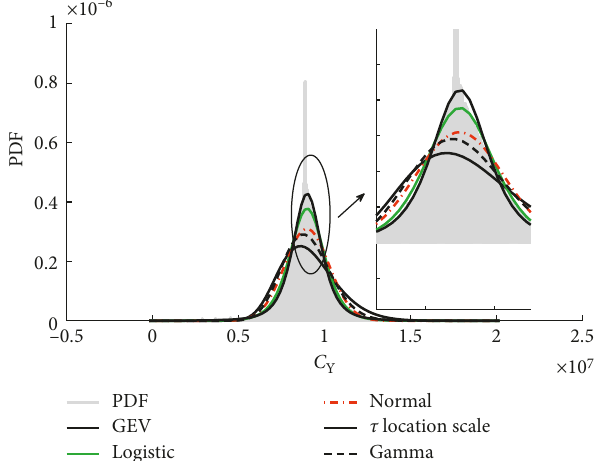
Figure 7: PDF fitting for lateral creep coefficient (GEV, generalized extreme